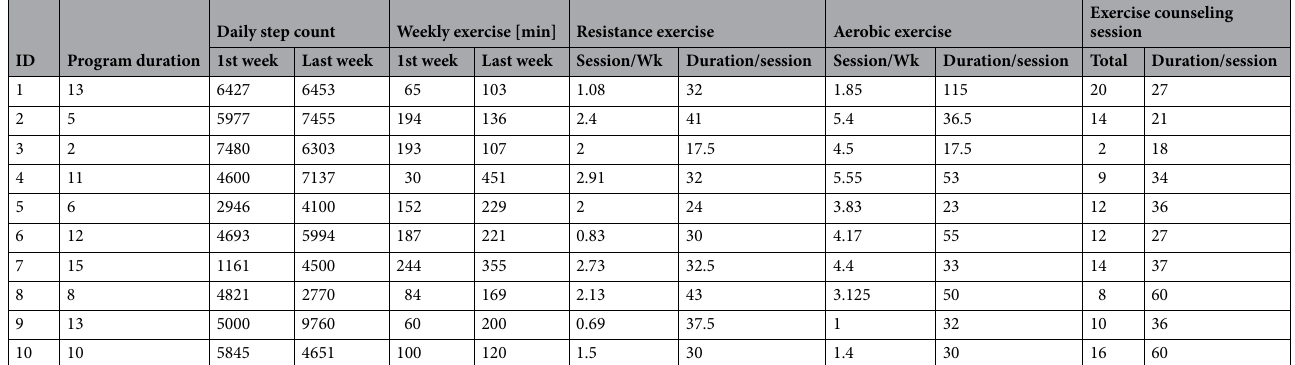
Table 2. Exercise metrics. ID: patient identifier, 1–10; Program Duration: unit = weeks; Weekly Exercise: data recorded voluntarily as exercise by patient on the polar watch, unit = minutes; Daily Step Count: data recorded by the polar watch, unit: mean step/day; Resistance Exercise and Aerobic Exercise: data recorded voluntarily as exercise by patient on the polar watch. 1st week : data collected during the patient’s first week of the program; Last week : data collected during the patient’s last week before their surgery; Session/wk : mean number of sessions per week; Duration/session : mean duration per session; unit: minutes; Total : total number of sessions through the program supervised by the exercise physiologist.